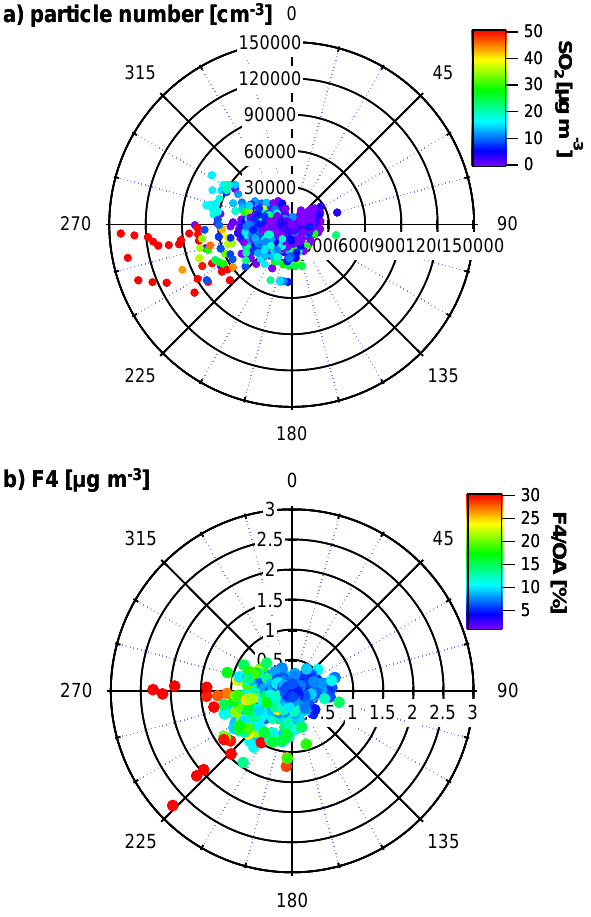
Fig.5: Polar plots of a) particle number colour coded by 1129 Fig. 5. Polar plots of (a) particle number color coded by SO 2 SO concentrations and b) concentrations of industrial 1130 2 concentrations and (b) concentrations of industrial factor F4 color factor F4 colour coded by the contribution of this factor 1131 coded by the contribution of this factor to total OA. to total OA. 1132